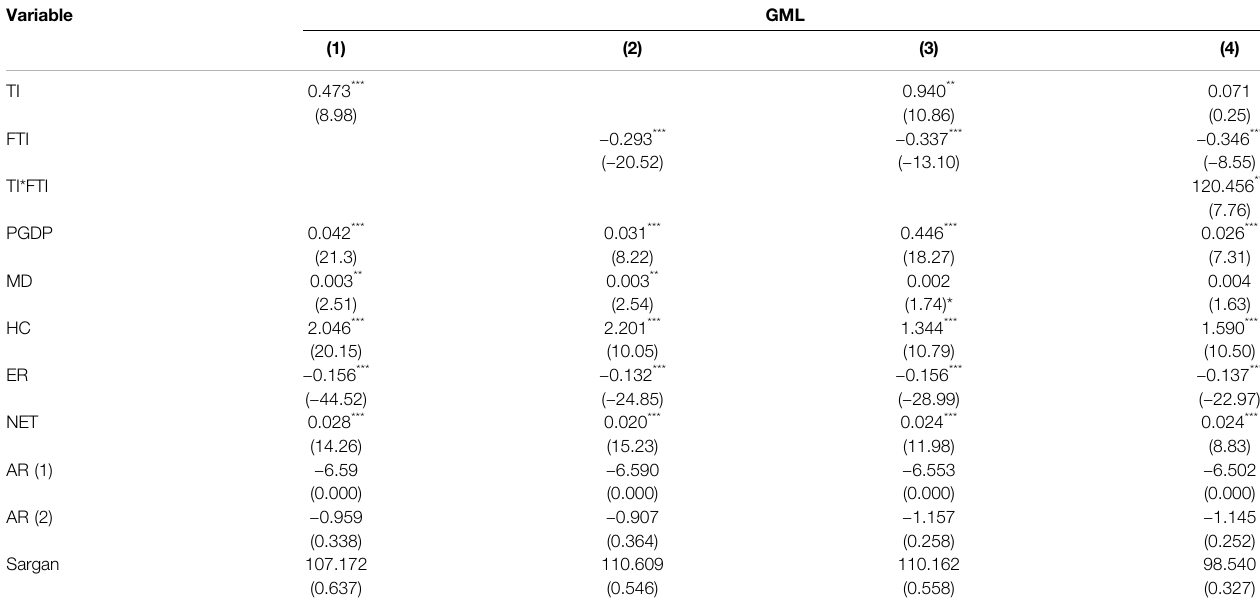
TABLE 4 | Estimation results of dynamic panel model.